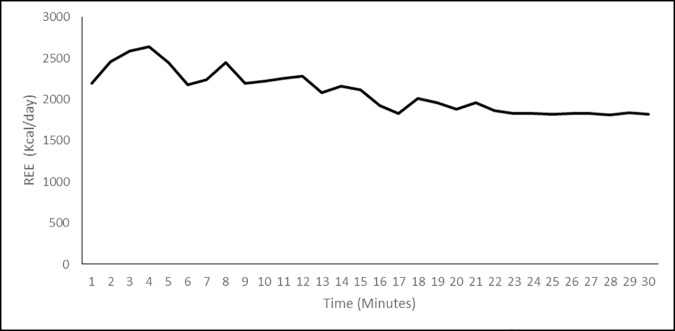
Pilot data of average REE over time in Control Participants.